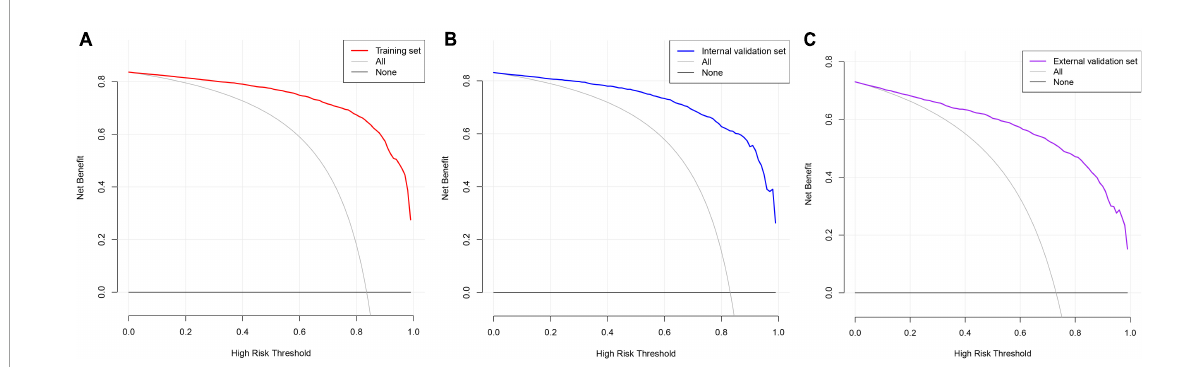
FIGURE7 Decision curve analysis. The black straight line represents the net benefit when none of the participants are considered to develop CAS, while the light gray curve represents the net benefit when all participants are considered to develop CAS. The area between the color (red, blue, and purple) curve and the light gray curve in the model curve indicates the clinical utility of the model. (A) Training set; (B) internal validation set; (C) external validation